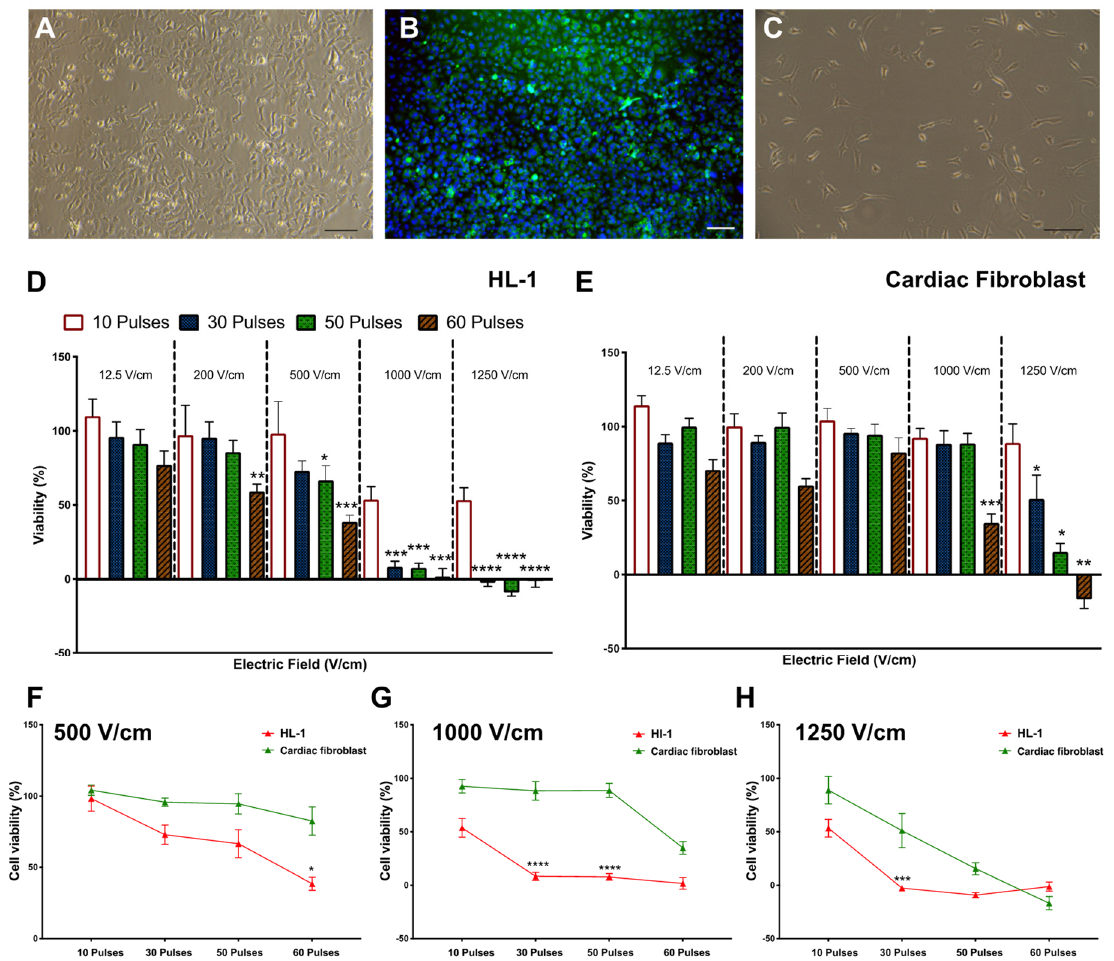
Figure 3. Cardiomyocyte and cardiac fibroblast viability are reduced by increasing electric field strength. ( A ) Representative brightfield image of HL-1 cells. ( B ) Fluorescent image of HL-1 cells stained for myosin (in green and nuclei counterstained with DAPI in blue). ( C ) Representative brightfield image of cardiac fibroblast. ( D ) HL-1 cells in suspension showed a significant reduction in cell viability at 60 pulses of all top voltages but substantially reduced to less than 10% viability at higher field strength of 1000 and 1250 V/cm. ( E ) Cardiac fibroblast cells in suspension only showed significant reduction at 1000 V/cm and 60 pulses with cell viability reaching less than 10% at 1250 V/cm and 60 pulses. The comparison of cardiomyocytes HL-1 cells and cardiac fibroblast shows that HL-1 cells have lower cell viability at 500 V/cm ( F ), 1000 V/cm ( G ), and 1250 V/cm ( H ). All data shown as mean ± SEM. Statistical significance performed using paired t -test and two-way ANOVA (* p < 0.05, ** p < 0.005, *** p < 0.001, **** p < 0.0001). Scale bar is 100 μ m.